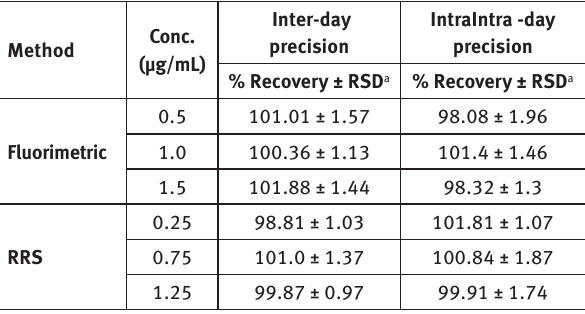
Table 3: Evaluation of inter-day precision and intra-day precision for the suggested spectroscopic methods